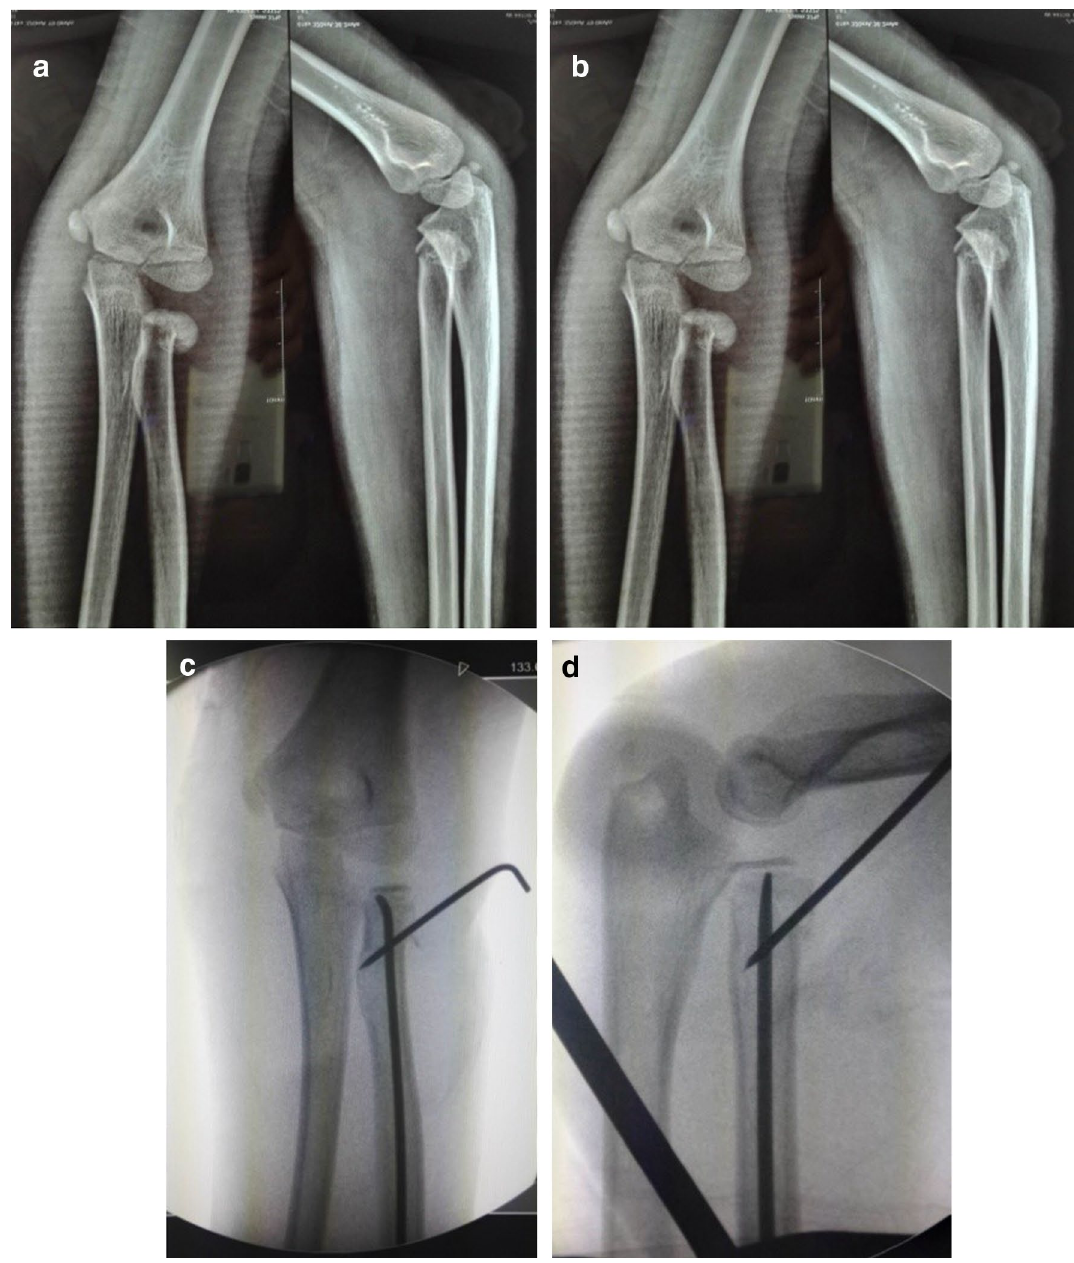
Figure 4. 7-year-old girl, left radial neck fracture, type II, PKWL + CIMP ( A ) and ( B ) preoperative, ( C ) and ( D ) elbow joint depends on the distal end of the brachial bone, the complete structure of the ruler’s proximal end, and the joint’s stability. Forearm rotation requires close coordination and compatibility of the ulnar and radial joints, and the proxi- mal axis of rotation is located at the center of the radial neck. Any deviation of the center of the radial head and neck of the radius can change the rotation radians of the radial head. If the head of the radius is shifted to the neck of the radius, the head of the radius will no longer perform smooth circumferential rotation, limiting the movement of pronation and pronation 13 . Several studies have proposed that more than 10% displacement destroys the compatibility of the proximal ulnar radial joint and inhibits radial head rotation around the radius 14 . Therefore, RNFs require sound reduction to avoid deformities. The radial head is covered with cartilage, and blood circulation is supplied from far to near. RNFs are similar to femoral neck fractures, where the blood supply is destroyed, and the radial head is prone to necrosis. Several recent studies have suggested closing manipulation or Kirschner’s wire reduction to treat pediatric RNF and reduce complications 15 . Many factors, such as age, the severity of the fracture, and the treatment method, are related to treatment outcomes. There are many treatment methods for RNFs in children. Furthermore, the different fracture types